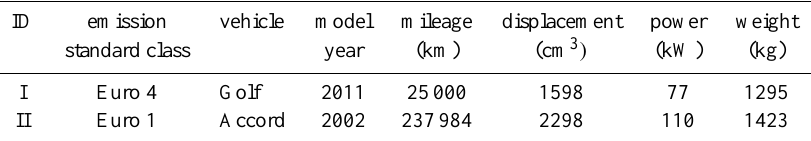
Table 1. Detailed information of the two light-duty gasoline